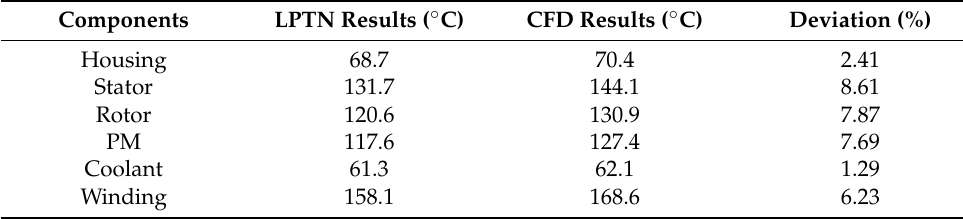
Table 7. Comparison of temperature calculation results under 2700 r/min @ 130 kW.